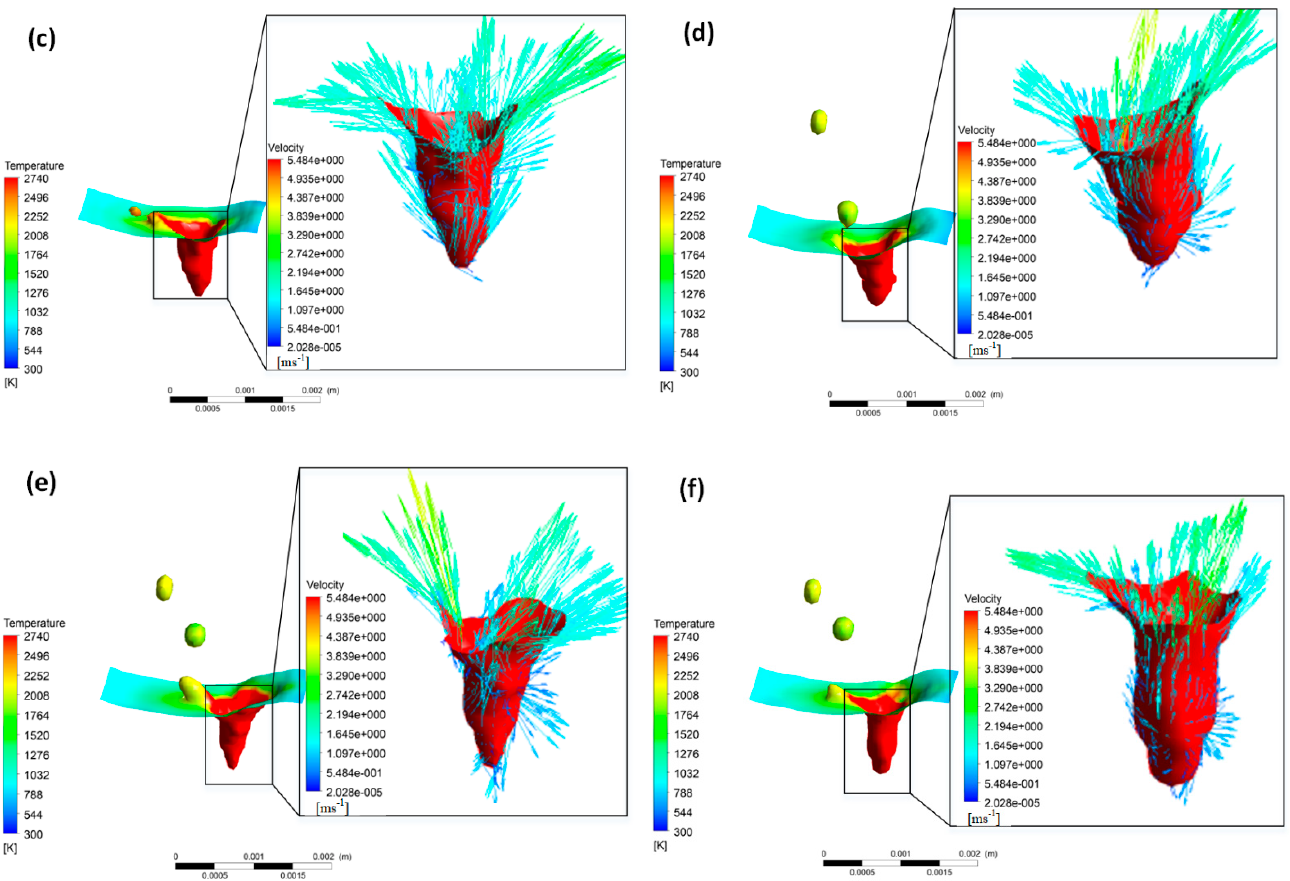
Figure 5. Three-dimensional transient behavior of the keyhole when the welding speed was 9 m/min: ( a ) t = 7.6 ms, ( b ) t = 7.9 ms, ( c ) t = 8 ms, ( d ) t = 12.5 ms, ( e ) t = 13.2 ms, ( f ) t = 13.4 ms.